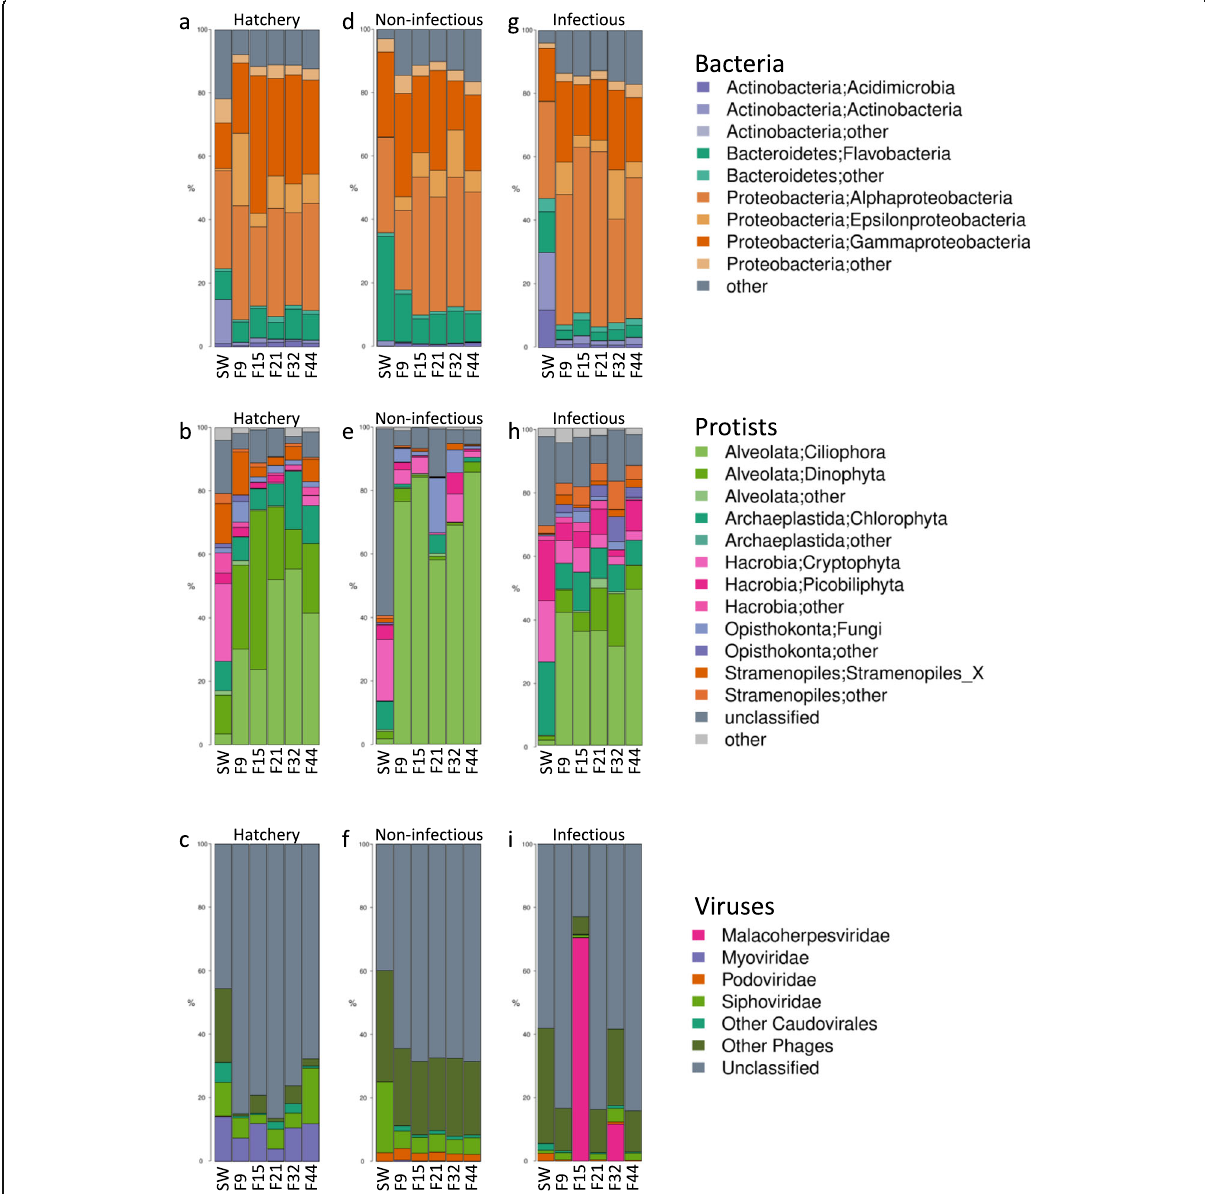
Fig. 2 Relative abundance of bacterial classes, protistan phyla and viral taxa in oyster hemolymph and seawater in controlled and natural conditions. a-c ) Hatchery, d-f ) natural environment during non-infectious and g-i ) infectious period. Bacterial classes and protistan phyla with relative abundance < 1% are grouped as “ other ” . The viral taxonomic affiliation was done on the 200 most abundant scaffolds, which represented 42.6% of the total reads ( c, f, i ). SW: